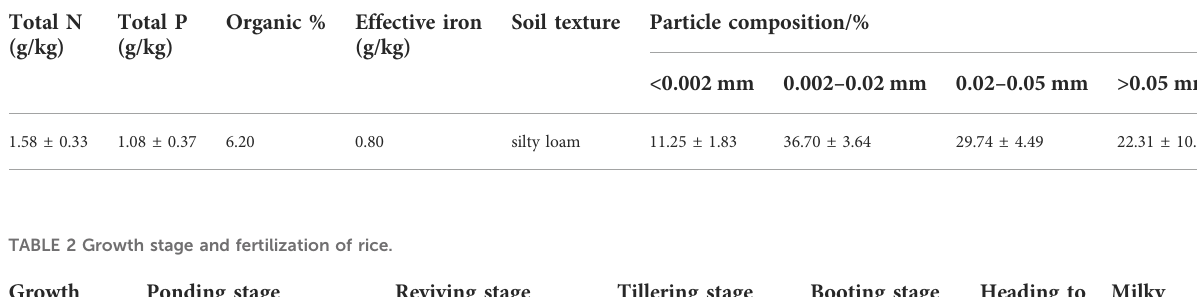
TABLE 1 Physicochemical characteristics of the paddy soils.